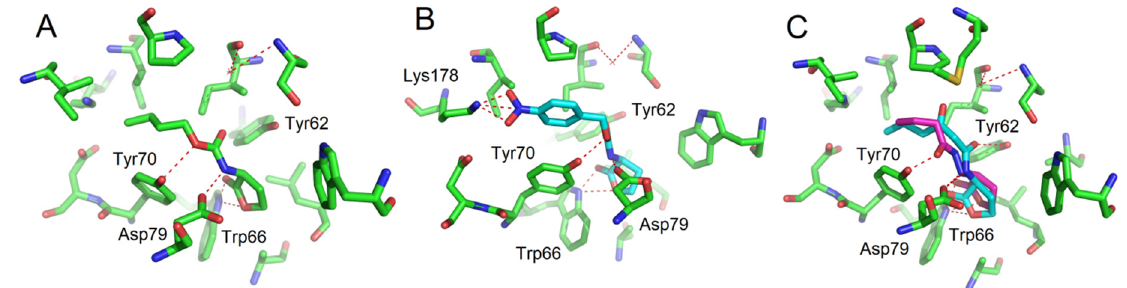
Figure 3. Proposed binding modes of compounds 2 ( A ) and 7 ( B ) within the binding site of the LuxR model obtained as a result of docking experiments. ( C ) Proposed binding modes of compound 12 (magenta) and OHHL (cyan) [30] obtained as a result of docking experiments. Hydrogen bonds are indicated in red dashes. Design of analogues of OHHL modified on the amide functional group.